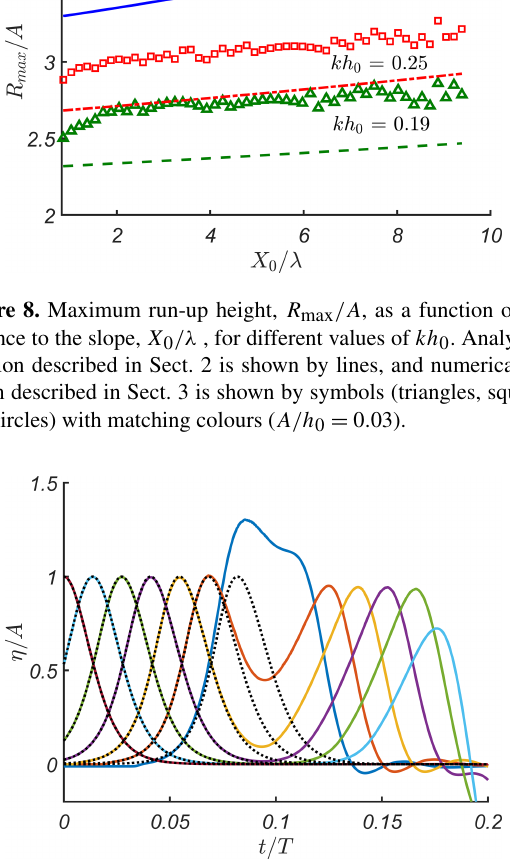
Figure 9. Wave evolution at different locations, x/λ = 0, 0.85, 1.71, 2.56, 3.41, 4.27 and 5.12, along the section of constant depth for a basin with X 0 /λ = 5 . 12 and tan α = 1 : 20. Numerical results are shown by solid lines, while the analytical predictions are given by the black dotted lines. The parameters of the wave are A/h 0 = 0 . 03 and kh 0 = 0 .